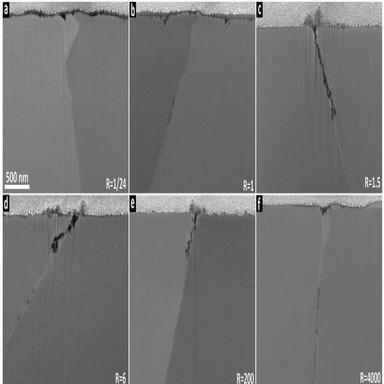
Overview of FIB-SE cross-section micrographs of samples exposed in H2-steam at: a) R ¼ 1/24, b) R ¼ 1, c) R ¼ 1.5, d) R ¼ 6, e) R ¼ 200 and f) R ¼ 4000.